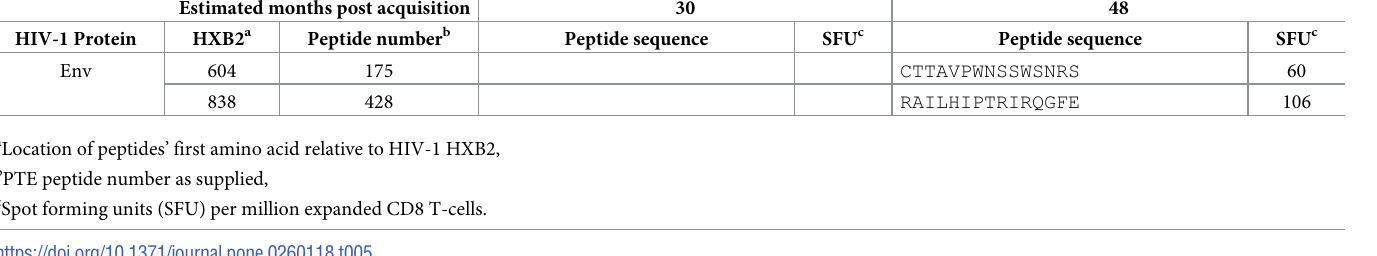
clade D: p = 0.182) (Fig 4B). Grouping all inhibition values by subject HIV-1 clade demon- strated that 66%, 78.3% and 40% of IMC were inhibited above the 0.8 log value by subjects living with HIV-1 clade A, clade C or clade D, respectively. Log